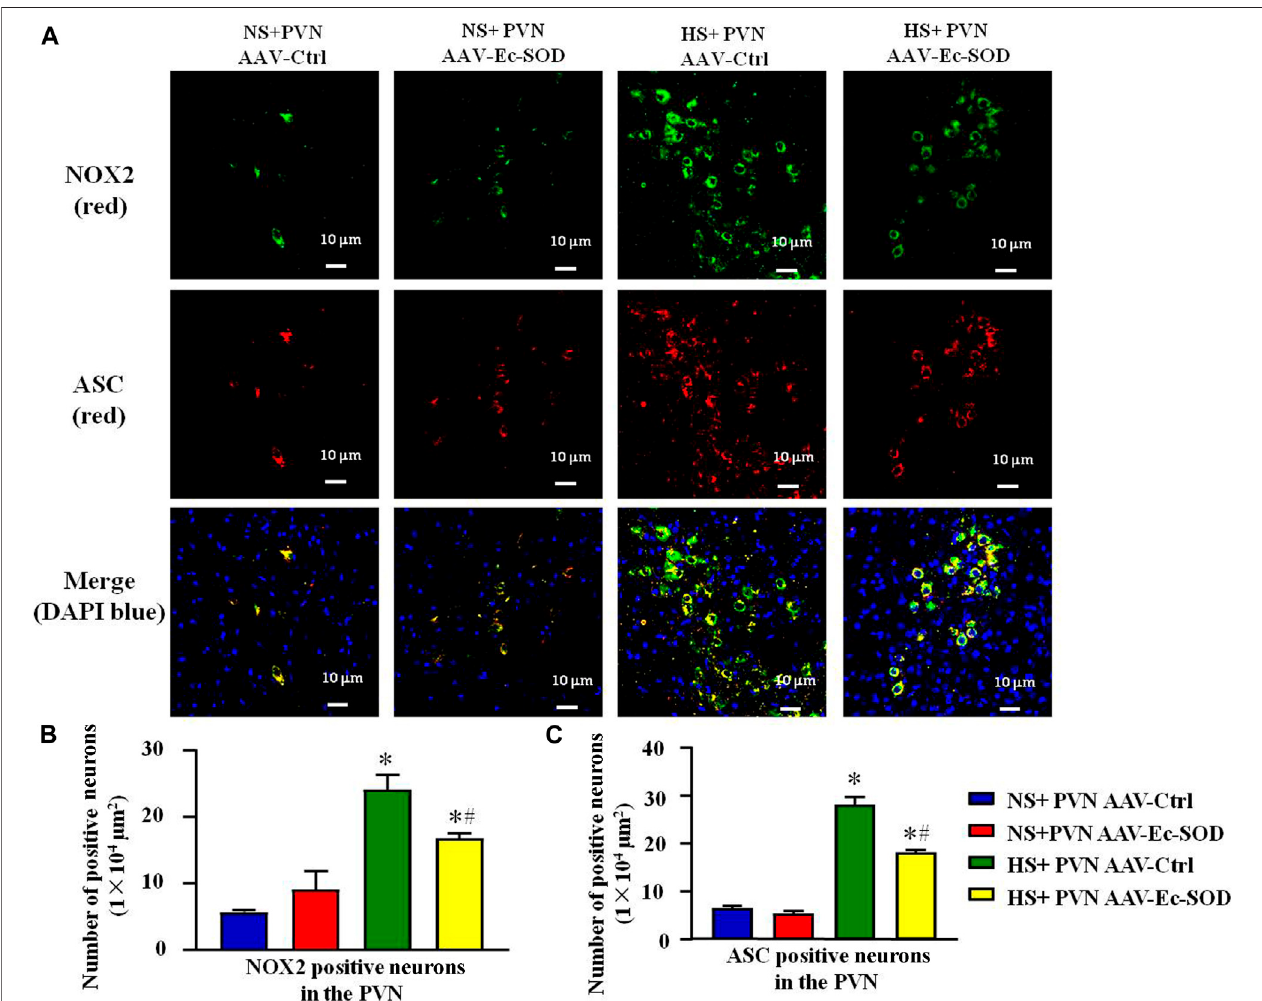
FIGURE 4 | Effect of AAV-Ec-SOD on NOX2 and ASC-positive neurons in the PVN. (A) Double fl uorescence staining for NOX2- and ASC-positive neurons in the PVN in different groups. (B – C) Column diagram showing the NOX2 and ASC-positive neurons in the PVN in different groups. Values are expressed asmean ± SEM (n (cid:2) 6). * p < 0.05 NS + PVN AAV-Ctrl vs. HS + PVN AAV-Ec-SOD; # p < 0.05 HS + PVN AAV-Ctrl vs. HS + PVN